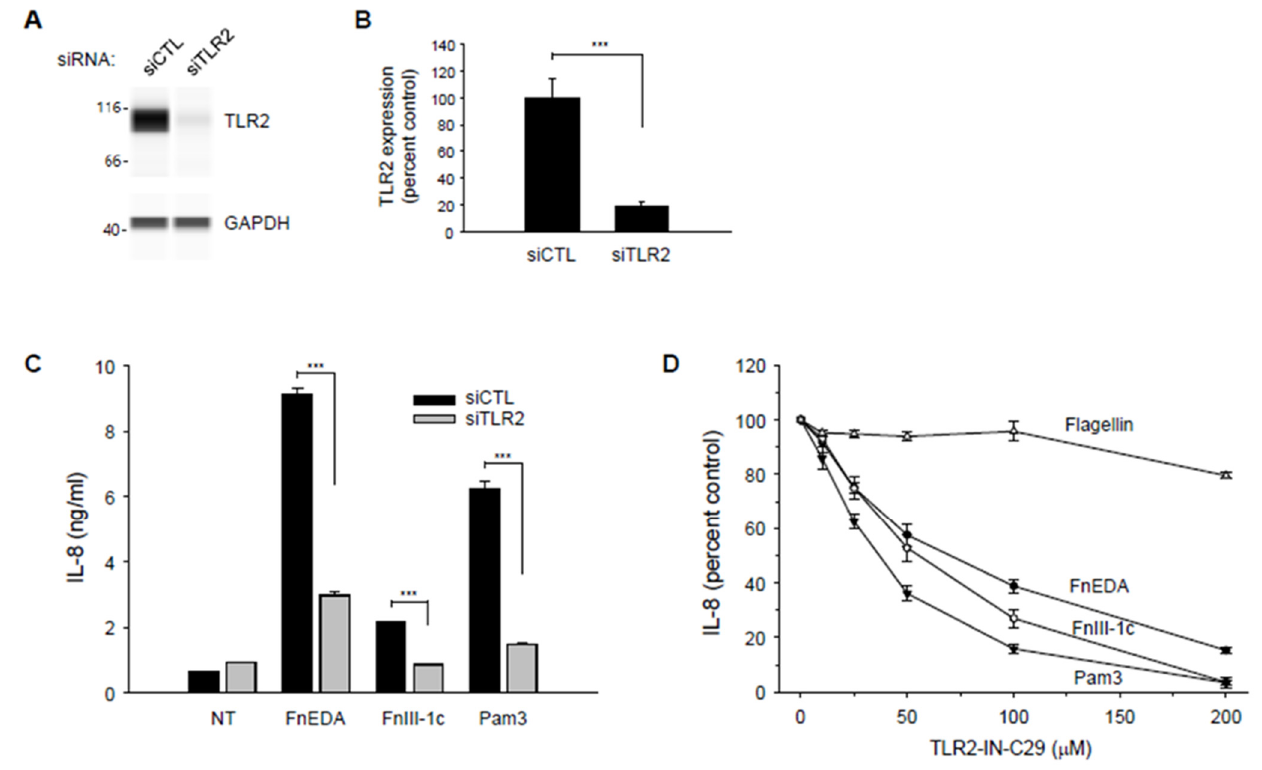
Figure 7. TLR2 knockdown suppresses FnEDA- and FnIII-1c-induced IL-8 synthesis in MDA-MB- 231 breast cancer cells. RNA interference was used to suppress expression of TLR2 (siTLR2) in MDA-MB-231 breast cancer cells. Non-targeting siRNA (siCTL) served as control. Representative Wes-ProteinSimple assay illustrating TLR2 expression levels following TLR2 knockdown are shown in ( A ) and quantified and normalized to GAPDH expression ( B , n = 3). ( C ) siRNA-treated MDA-MB-231 cells were incubated with either FnEDA (5 µ M), FnIII-1c (10 µ M), or the TLR2 agonist, Pam3CSK4 (Pam3, 0.1 µ g/mL) for 4 h. Conditioned medium was collected, and IL-8 concentration determined by ELISA. Data represent the mean ± SEM of three independent experiments.